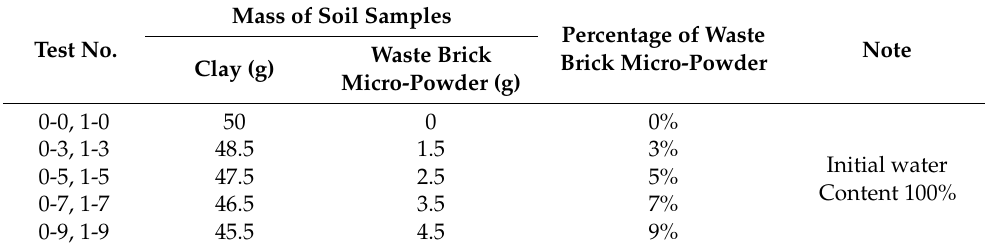
Table 2. Test design of the samples.